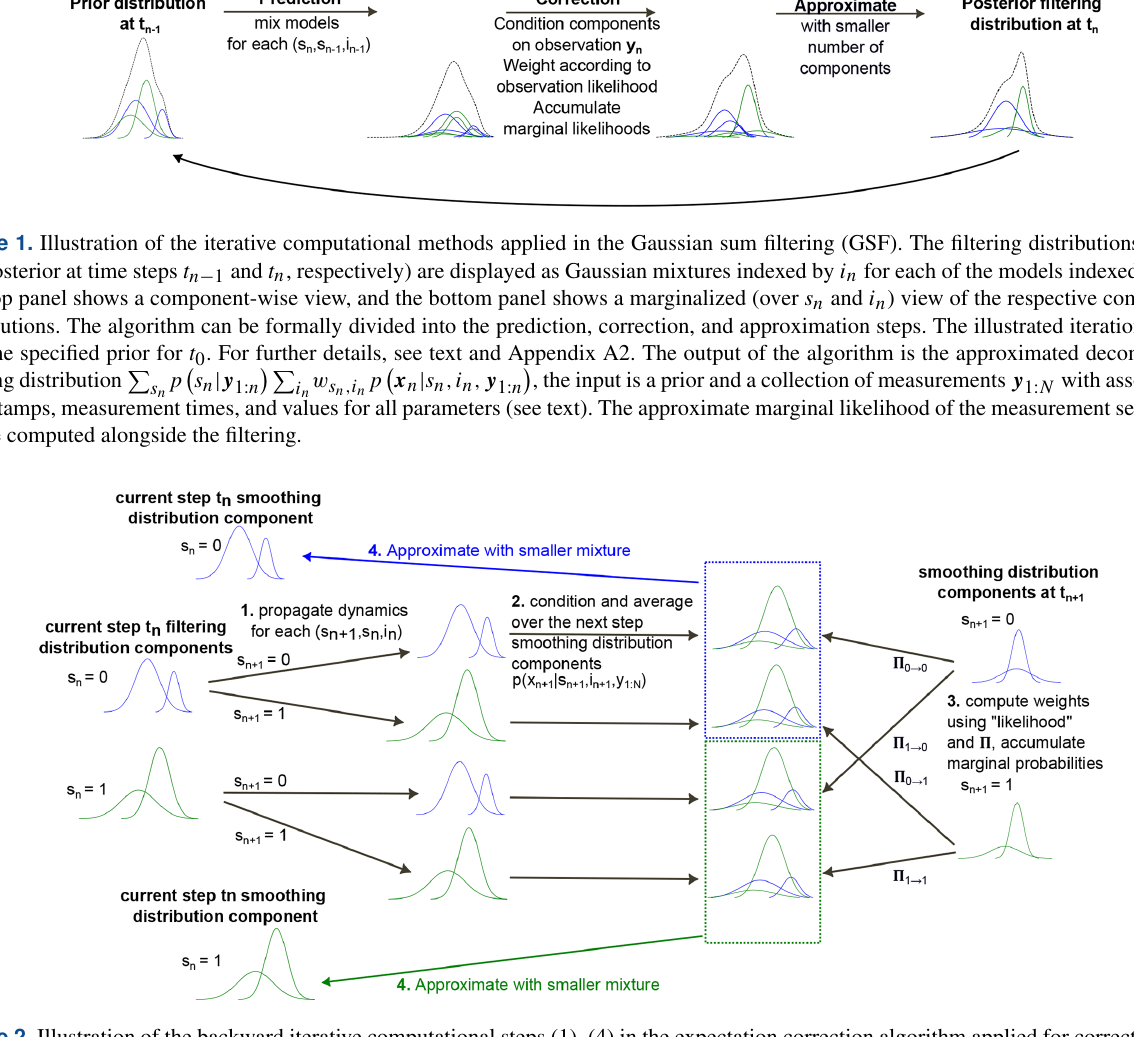
Figure 2. Illustration of the backward iterative computational steps (1)–(4) in the expectation correction algorithm applied for correcting the results from the Gaussian sum filtering (GSF) outlined in Fig. 1 to the approximate smoothing solution in the switching linear dynamical sys- tem. Input to the algorithm are the results from the GSF and associated time stamps and values for all parameters. Output is the decomposed p (cid:0) s n | y 1 : N (cid:1)(cid:80) i w s p (cid:0) x n | s n ,i n , y 1 : N (cid:1) as a Gaussian mixture smoothing distribution (cid:80) s n ,i n n n